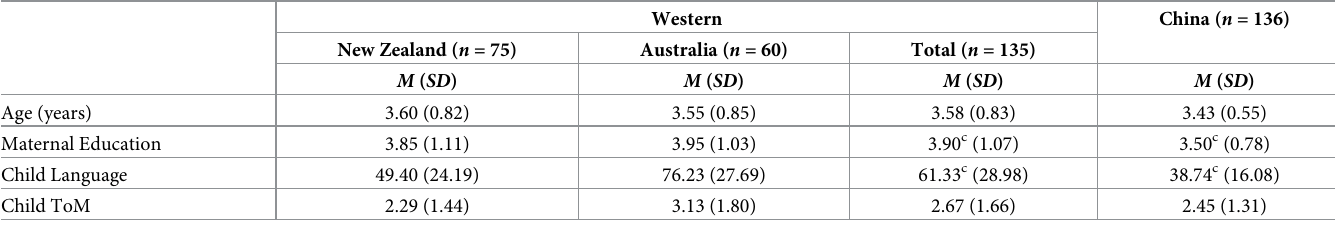
Table 1. Descriptive statistics for the key variables in three countries.